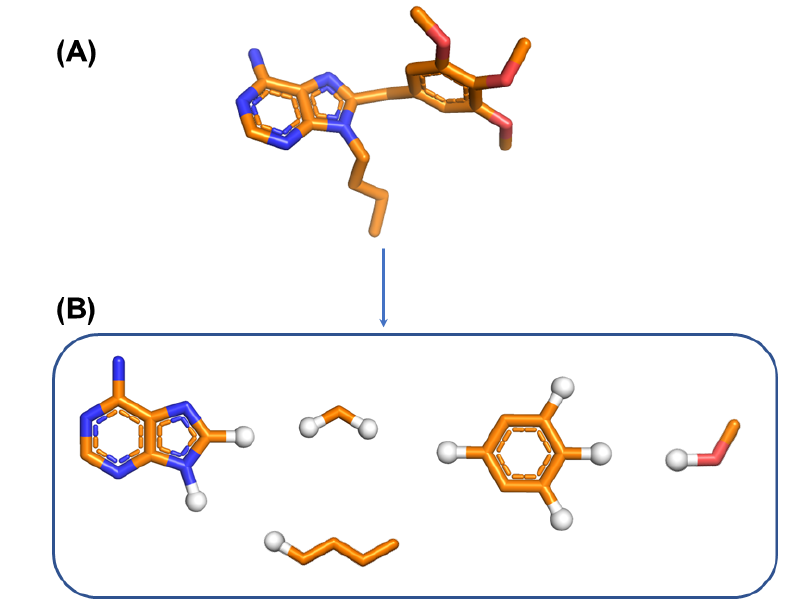
Figure 2. ( A ) PU3 ligand of Hsp90 and ( B ) The five sub-ligands from